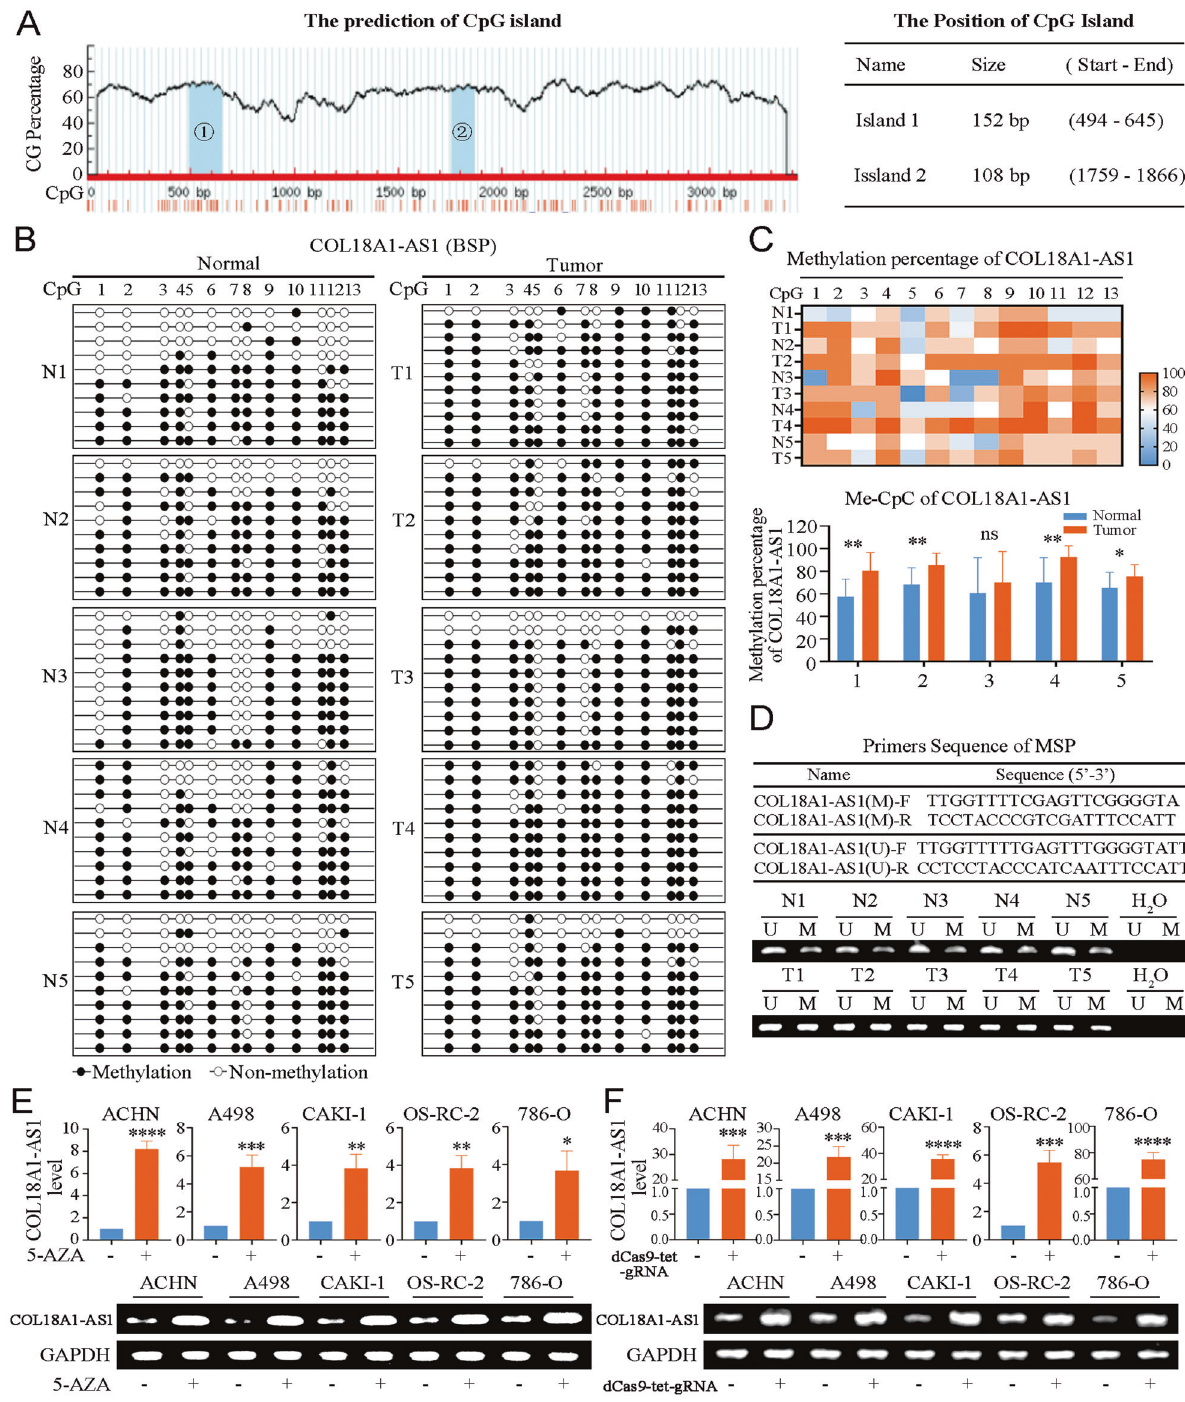
Fig. 3 DNA methylation caused the low expression of COL18A1-AS1 in ccRCC. A Prediction analysis of CpG islands in the sequence range of 3400 bp upstream from the transcriptional start site in the COL18A1-AS1 promoter region. B BSP results of COL18A1-AS1 methylation status in adjacent tissues and ccRCC tissues. C Heat map of methylation percentage of COL18A1-AS1 and histogram of quantitative results. D The primers sequence of MSP and representative MSP results of COL18A1-AS1 methylation status in adjacent tissues and ccRCC tissues. E The expression levels of COL18A1-AS1 in RCC cell lines after 5-AZA treatment. F The expression levels of COL18A1-AS1 in RCC cell lines after CRISPR/dCas9-mediated editing system speci fi c demethylation. * P < 0.05, ** P < 0.01, *** P < 0.001, **** P < 0.0001. Error bars indicate mean ± SD. All the experiments were performed in